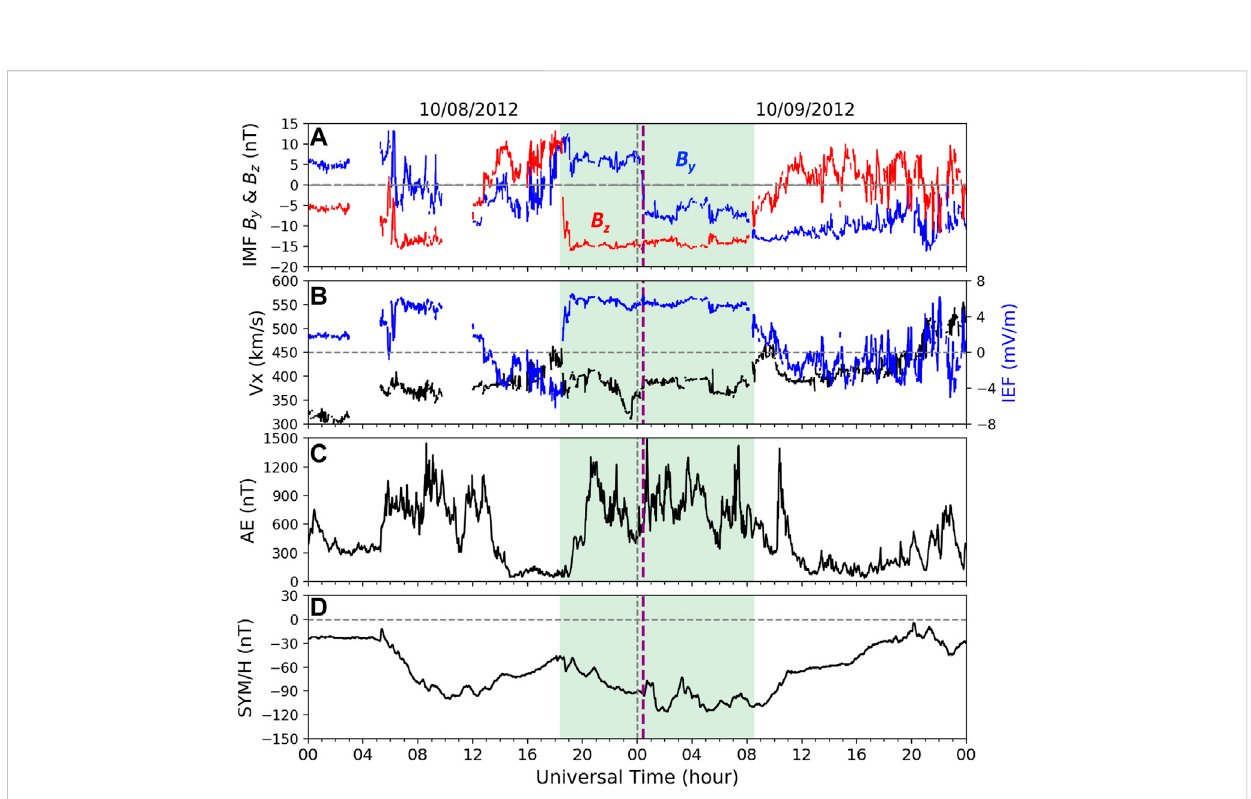
FIGURE 2 (A) Interplanetary magnetic fi eld (IMF) B y and B z components, (B) solar wind velocity V x and interplanetary electric fi eld (IEF, E = − V x x B z ), (C) auroral electrojet AE index, and (D) SYM/H index during October 8 – 9, 2012. The green shaded area highlights the period of interest in this study. The vertical purple dashed line marks the IMF B y reversal time, which is around 00:20 UT on October 9